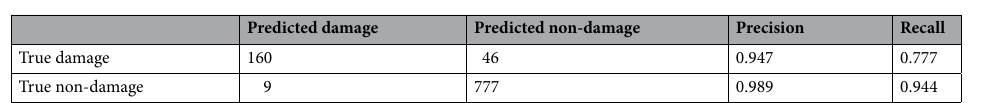
Table 2. Confusion matrix for the near-real time test on M7.0 Turkey Earthquake after removing duplicate